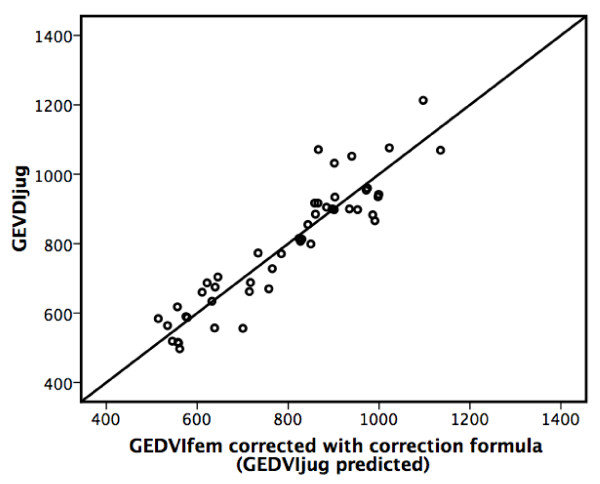
Femoral global end-diastolic volume index corrected by the correction formula. Scatter plot illustrating the predictive capability of the correction formula of jugular global end-diastolic volume index (adjusted r2 = 0.75). GEDVIjug, jugular global end-diastolic volume index (mL/m2).